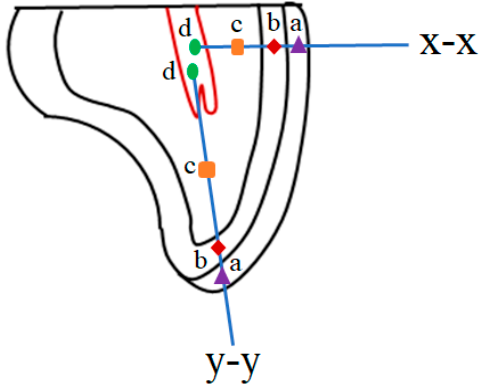
Figure 7. Calculated temperature change at the 4 points along both the x-x and y-y directions. ( a ) Veneer, ( b ) enamel, ( c ) dentin, and ( d )